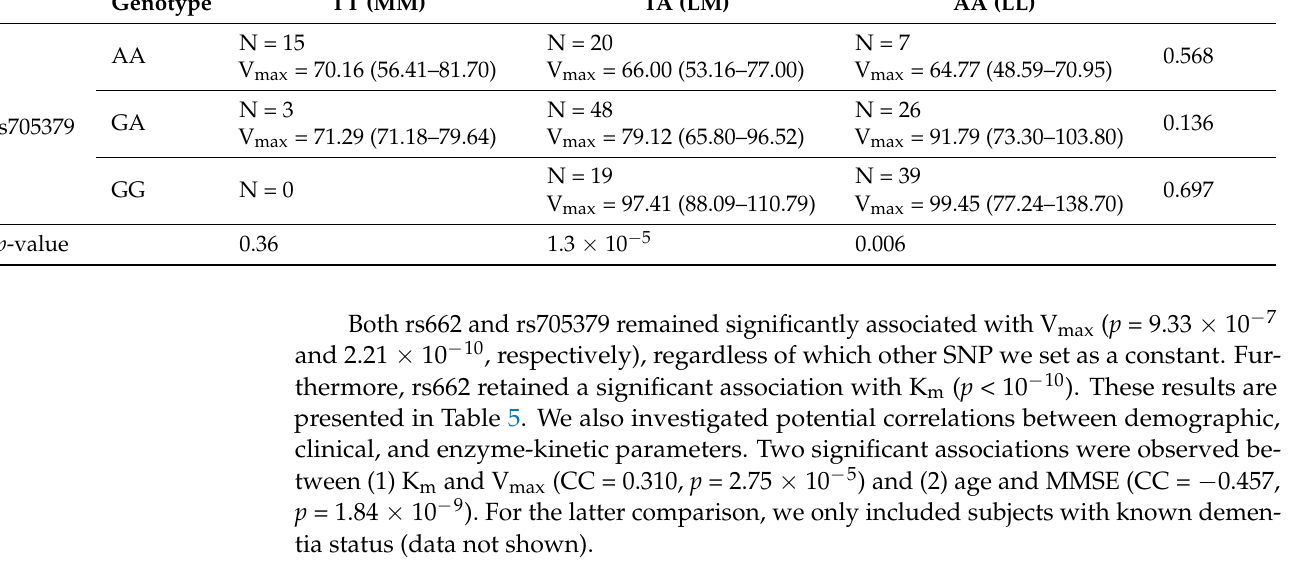
Table 5. Average K m and V max values for each rs662/rs705379 genotype. Genotype-kinetics associa- tions that were below the significance threshold because of linkage disequilibrium are not